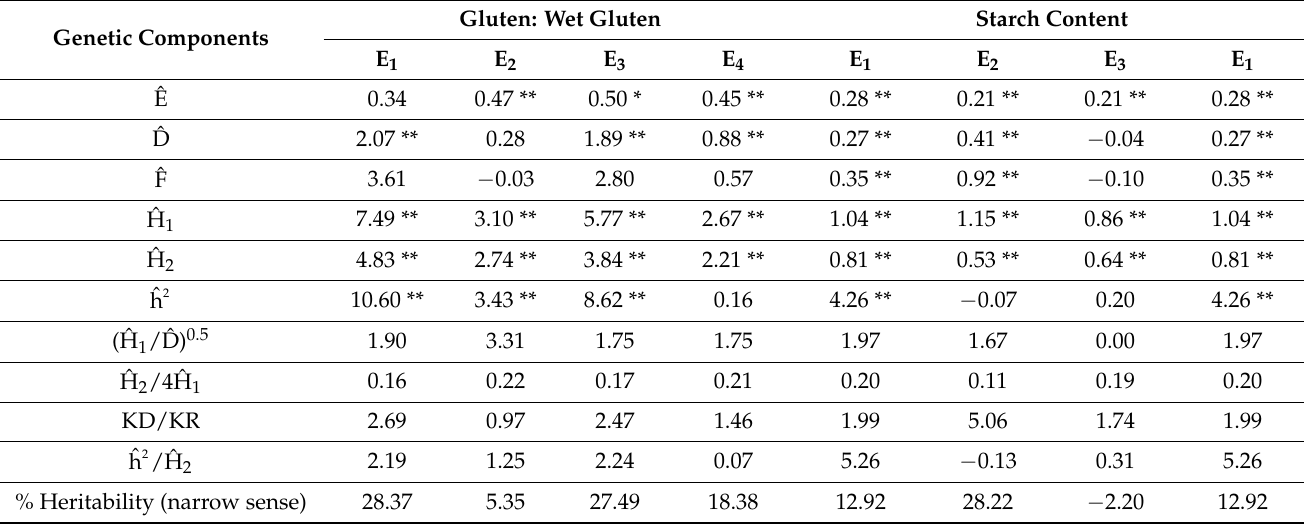
Table 4. Genetic components of gluten: wet gluten and starch content. Genetic